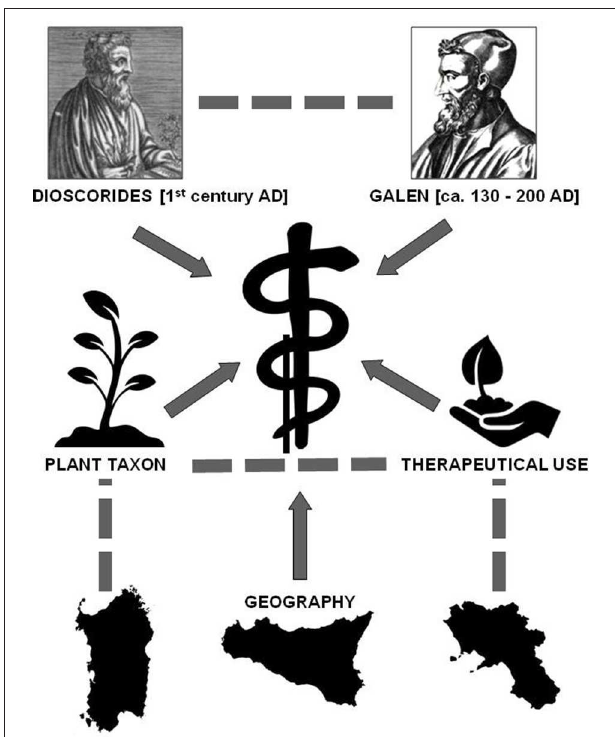
FIGURE 4 | Causal model assuming that Dioscorides and Galen influenced contemporary medicinal plant use considering the confounding variables “plant taxon,” “geography,” “therapeutical use” and their interactions (segments). Arrows indicate the direction of the influence, which may exert a causal